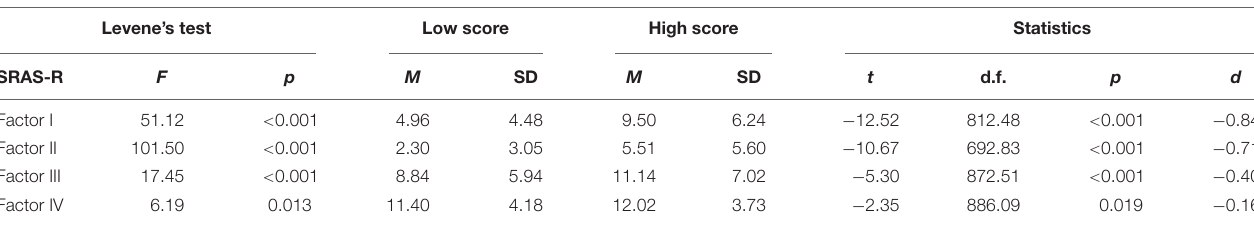
TABLE 5 | Differences in school refusal behavior in students with high and low scores on Hostility. Levene’s test